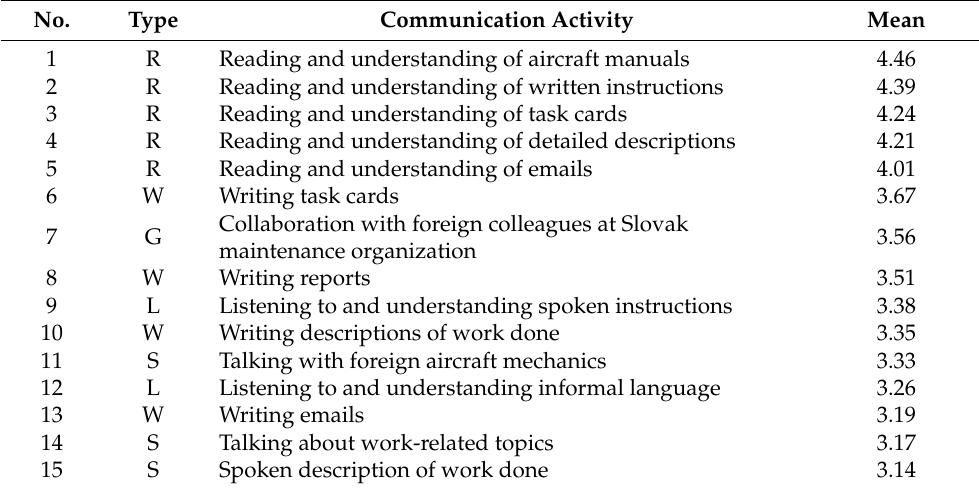
Table 6. Most relevant communication